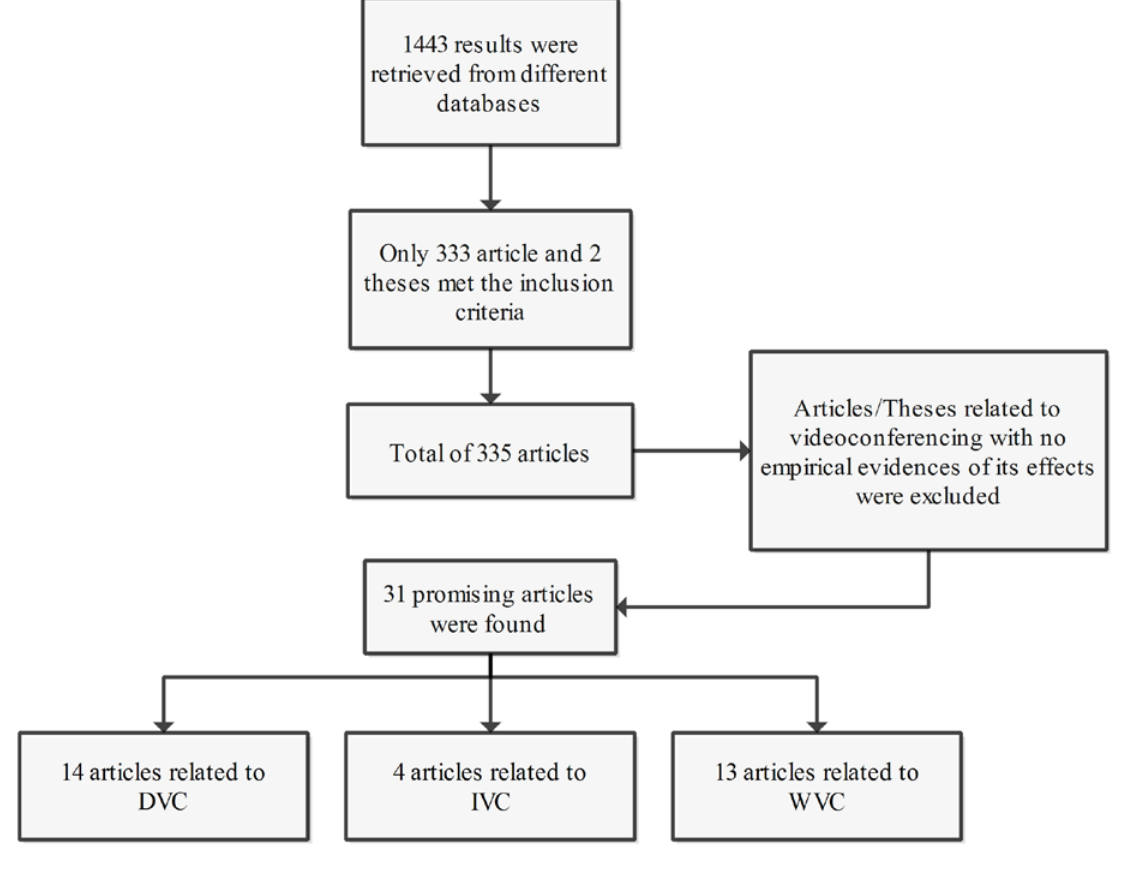
Figure 2 . Articles selection flow